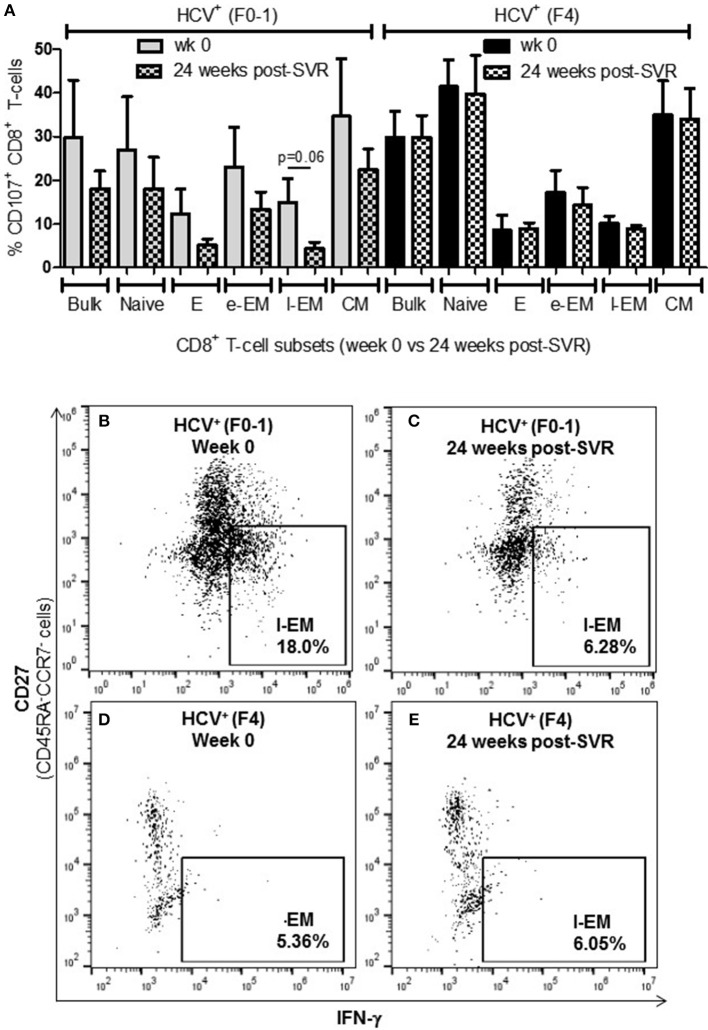
Levels of cell degranulation marker expression are sustained after HCV cure in individuals with advanced liver fibrosis. The presence of CD107a was evaluated in in vitro stimulated CD8+ T-cells isolated from HIV-infected individuals before treatment with direct-acting anti-HCV therapy (DAA) and 24 weeks post-SVR. (A) These data are summarized in a bar graph showing data for individuals with minimal liver fibrosis on the left and advanced fibrosis on the right (n = 4 in each study group). Data for week 0 data are shown in solid colored bars while data for 24 weeks post-SVR are shown in hatched bars. (B,C) Representative dot plots demonstrate the reduction in detectable CD107a+ l-EM cells from week 0 to 24 weeks post-SVR in an individual with minimal fibrosis. (D,E) Additional representative dot plots contrast the latter with sustained CD107a levels in l-EM cells of an individual with advanced liver fibrosis before and after DAA therapy.